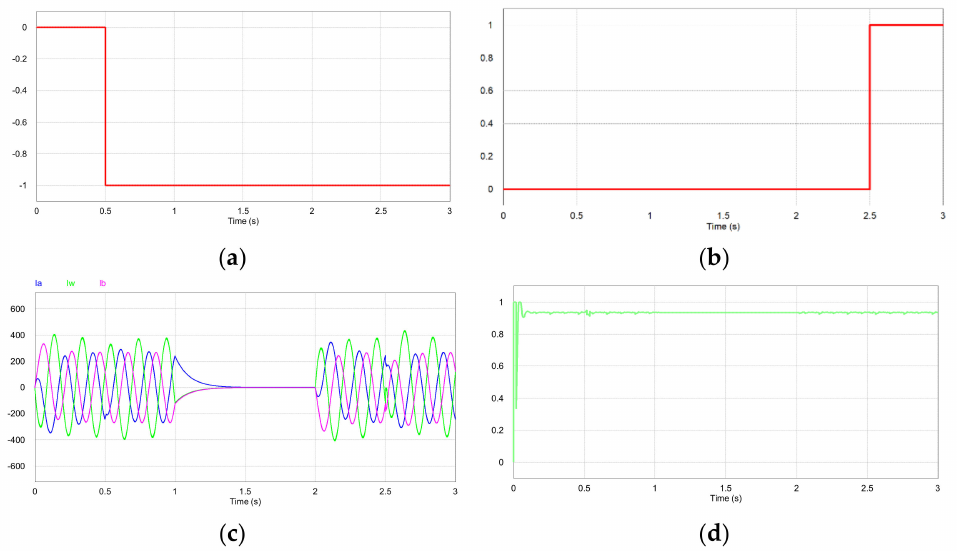
Figure 10. Faulty V 1 at t = 0.5 s and faulty V 4 at t = 2.5 s. ( a ) faulty signal of V 1 ; ( b ) faulty signal of V 4 ; ( c ) Output currents; ( d ) power